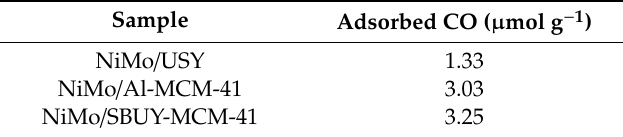
Table 3. Adsorbed CO determined by TPD characterization.